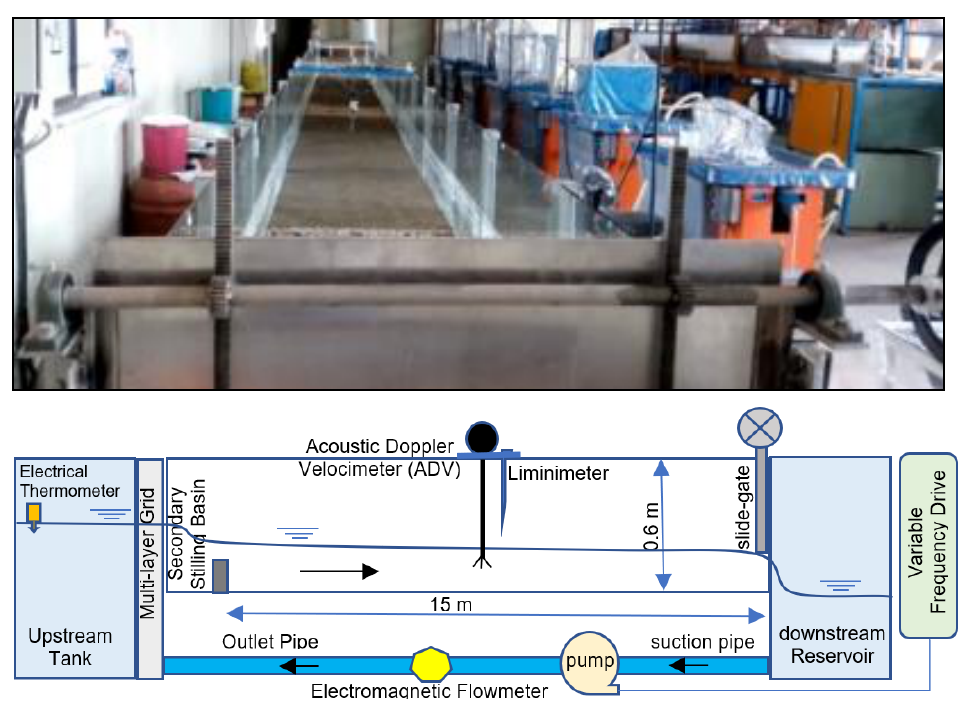
Figure 1. Flume used for experiments (dimensions: 15 m long, 0.9 m wide, and 0.6 m deep).